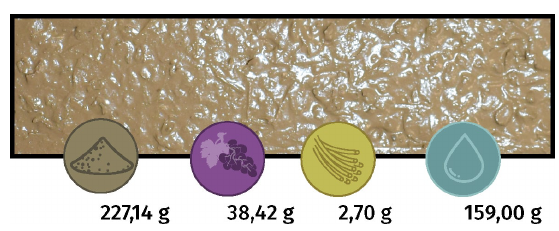
Table 3. Mix-design prototype 2.